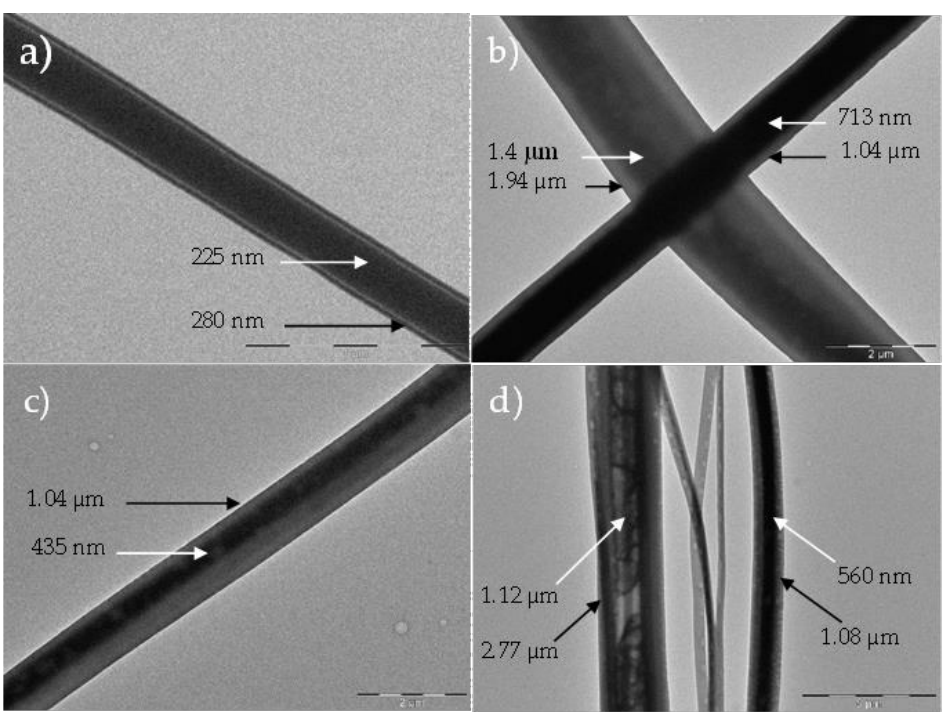
Figure 6. TEM images of coaxial nanofibers (P3HT/PS core (white arrow) with BBL shell (black arrow)) created simultaneously within a single run of the electrospinning technique. Scale bars are 1 µ m ( a ), 2 µ m ( b , c ), and 5 µ m ( d